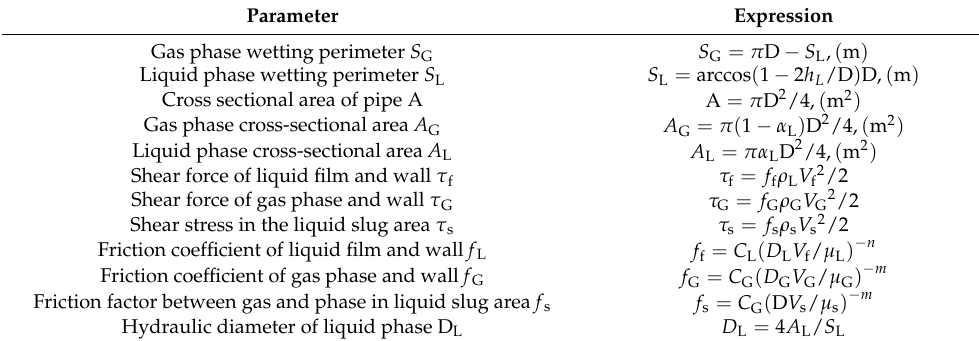
Table 2. Parameter calculation method.